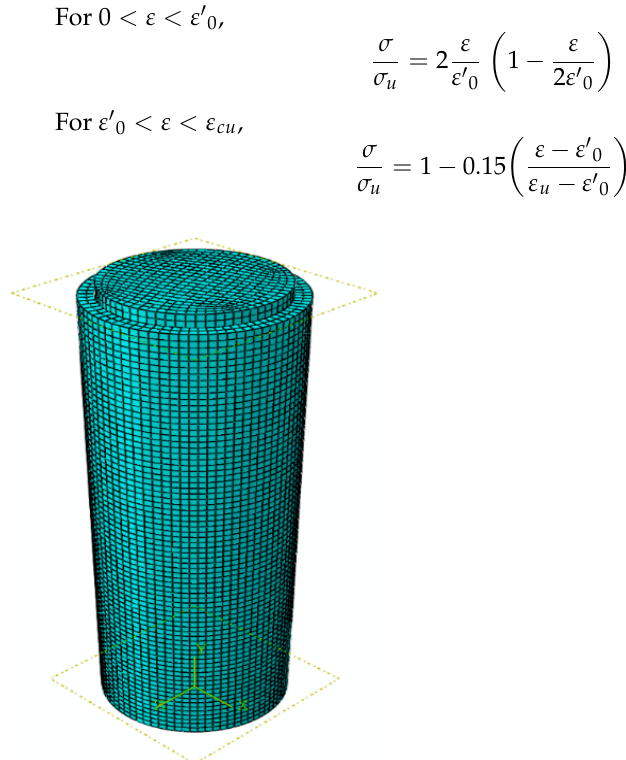
Figure 8. Meshed model of the confined column with cut ends of PVC.